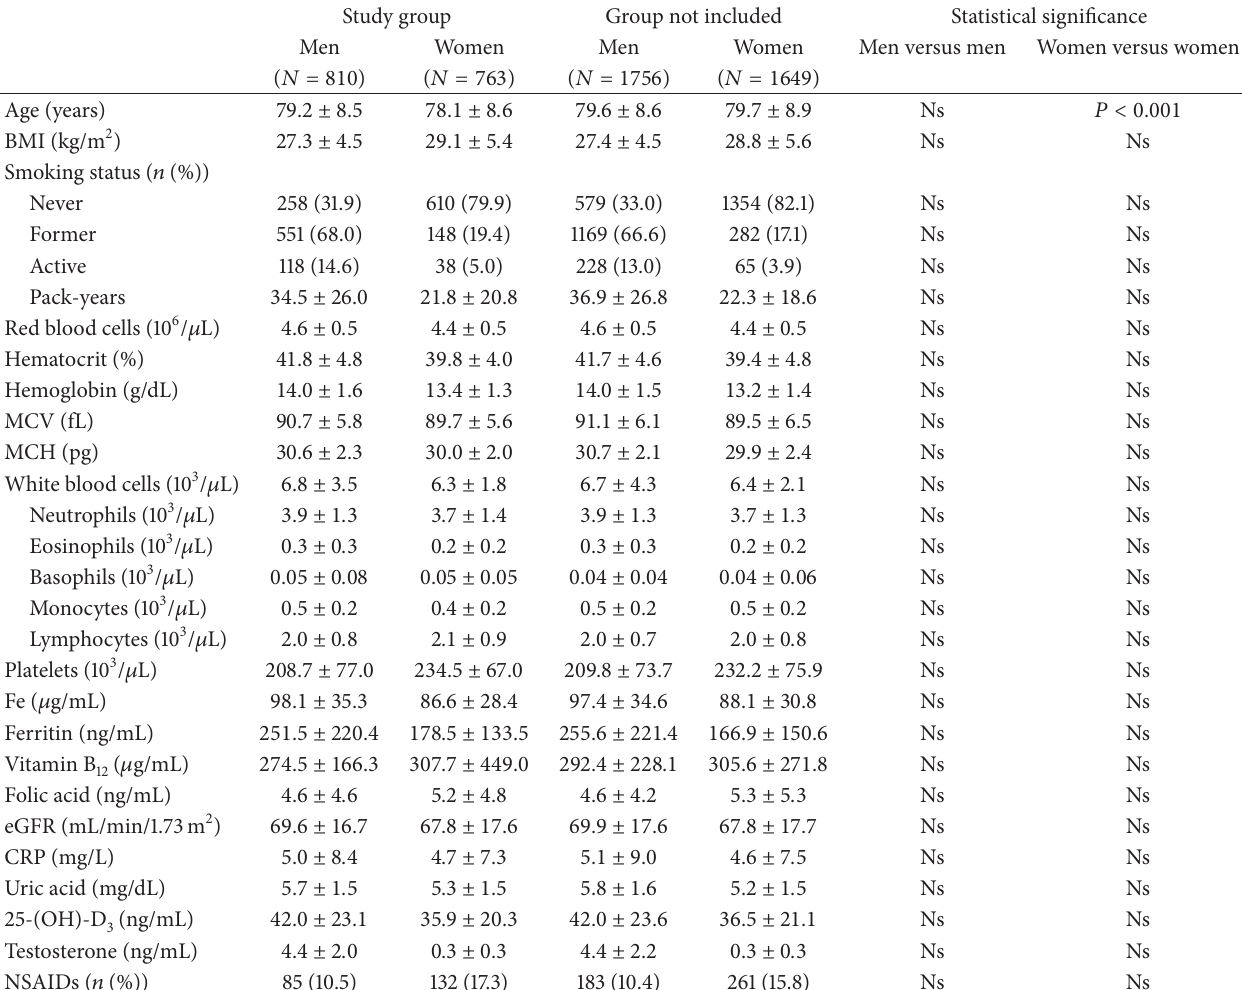
Table 1: The characteristics of study group and its comparison with the group without assessment of telomere lengths and peripheral blood